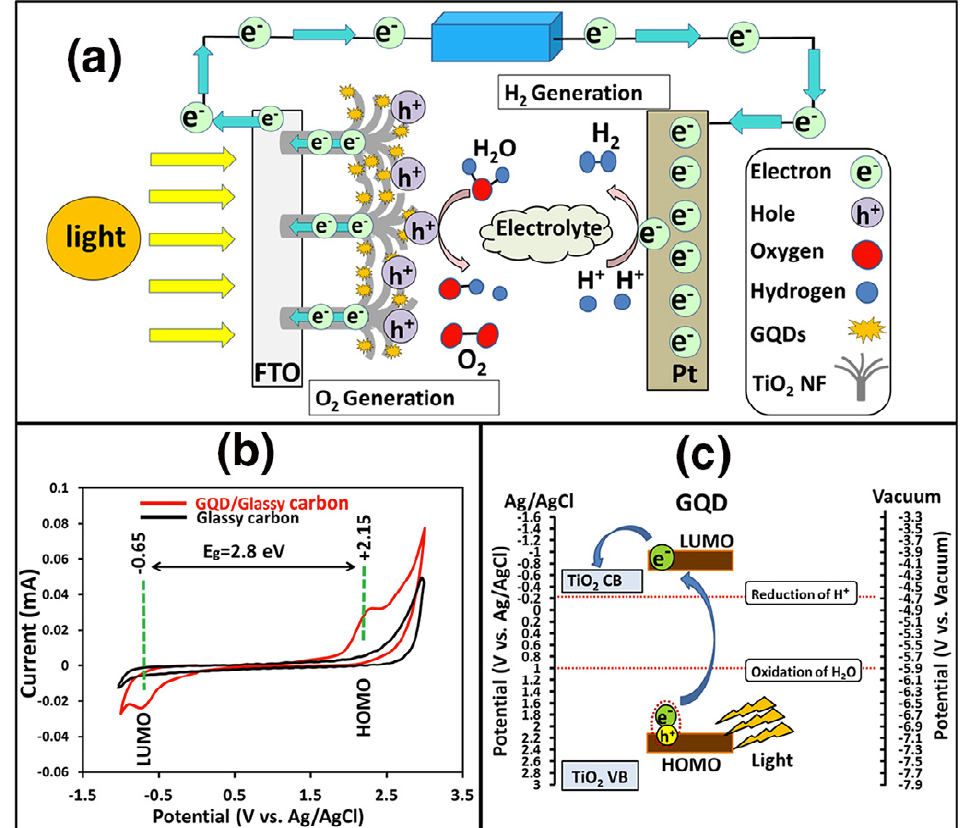
Figure 30. ( a ) Schematic illustration of H 2 and O 2 generation under illumination, ( b ) Cyclic Voltammetry (CV) measure- ments for determination of highest occupied molecular orbital (HOMO) and Lowest unoccupied molecular orbital (LUMO) energy levels, and ( c ) charge transfer mechanism at GQD/TiO 2 NF interface. Figure 30 reprinted with permission from [91]. Copyright @ 2017